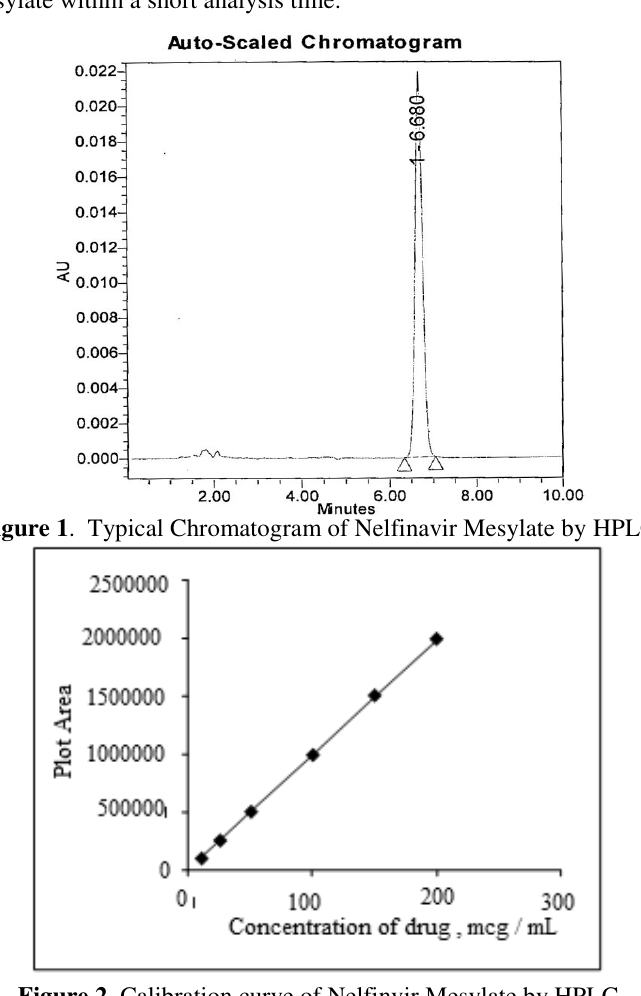
Figure 2. Calibration curve of Nelfinvir Mesylate by